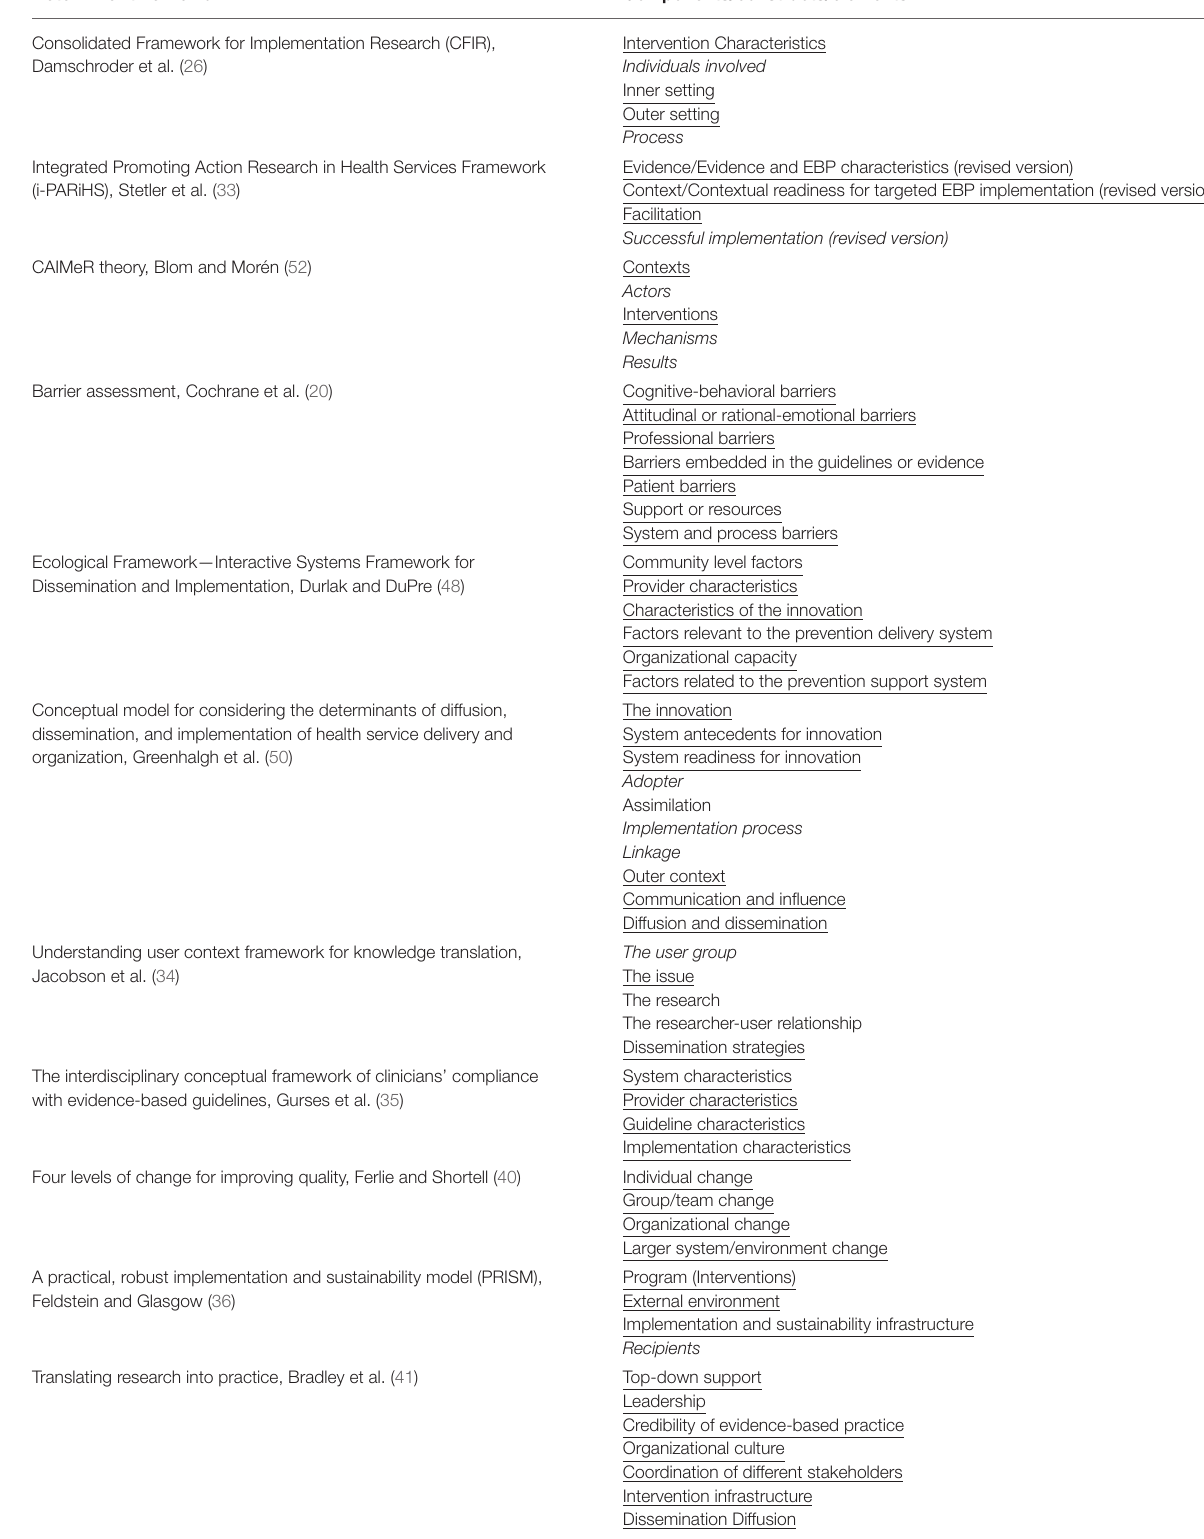
TABLE 5 | Overview of determinant frameworks with their main components, constructs, or elements. Determinant